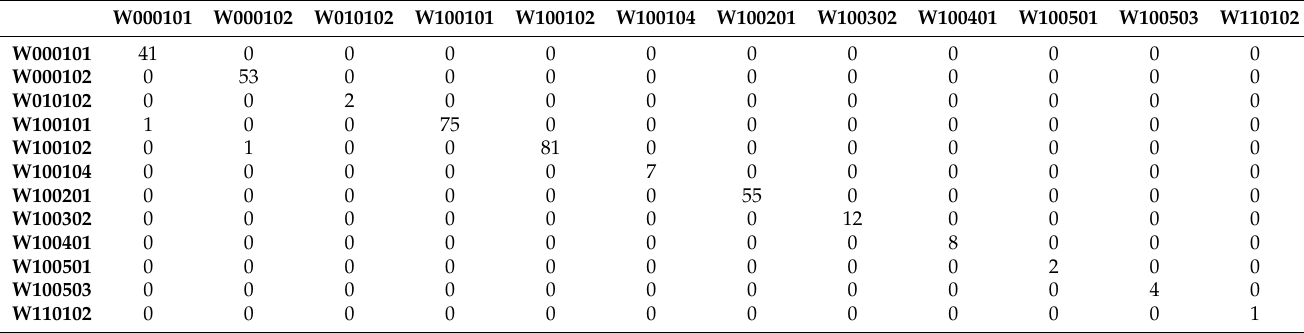
Table 7. Confusion